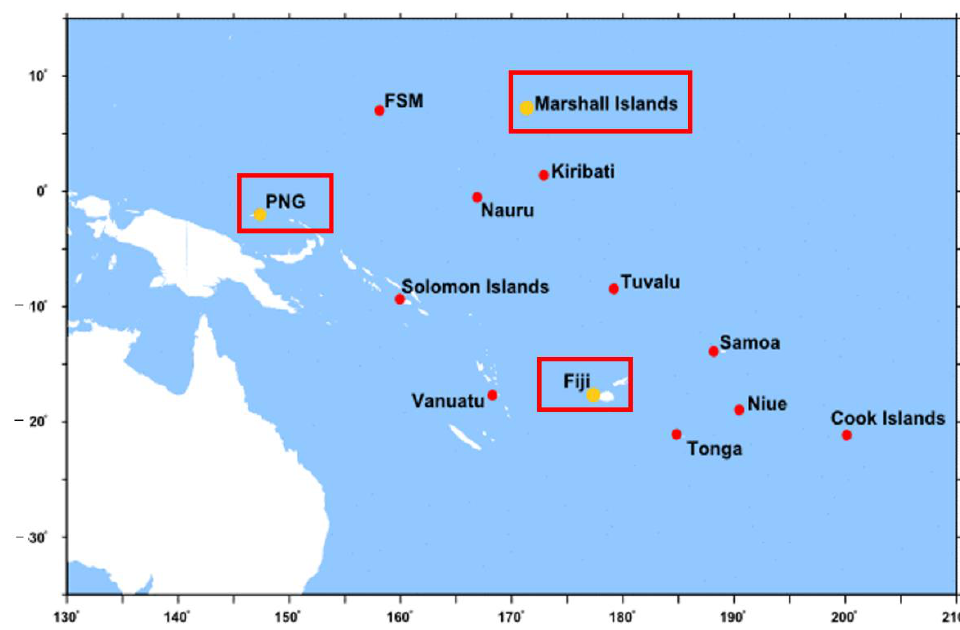
Figure 1. Study region showing the selected Pacific Islands (i.e., Fiji, Marshall Island and PNG). Source: Pacific Sea Level Monitoring Project (bom.gov.au, accessed on 10 May 2021).